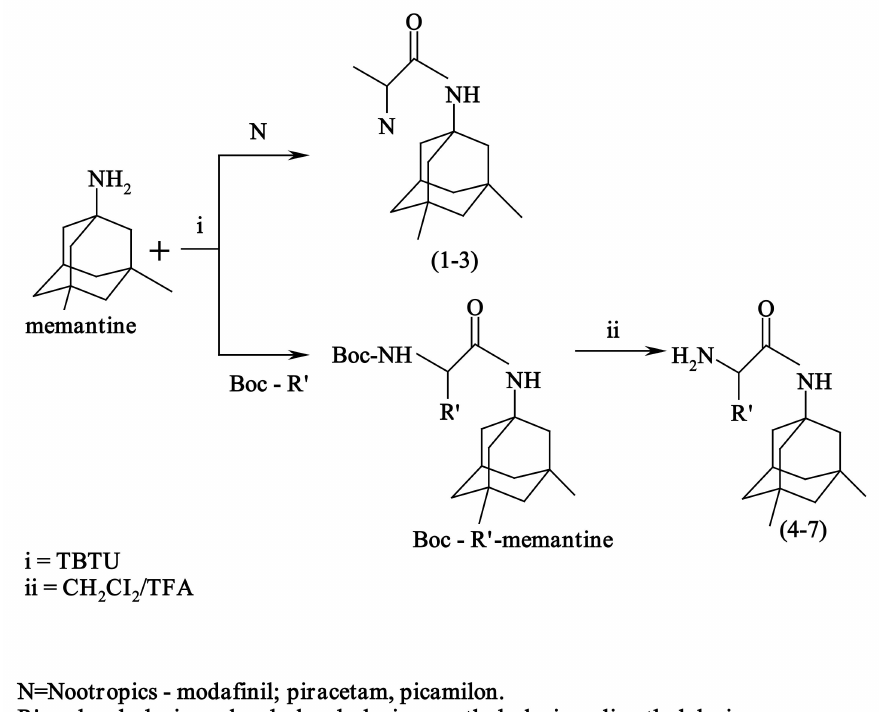
Scheme 1. Synthesis of nootropics and glycine derivatives of memantine.